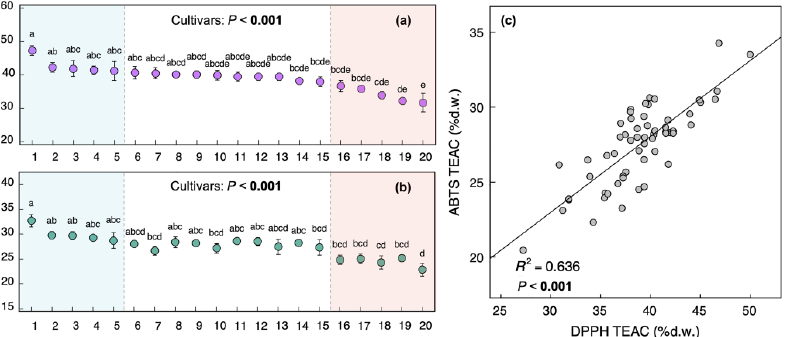
Figure 1. Variations in radical scavenging capacity within tea leaves across 20 tea cultivars. Radical scavenging capacity is presented as Trolox equivalent antioxidant capacity (TEAC). ( a ) TEAC in DPPH (2,2-diphenyl-1-picrylhydrazyl) radical scavenging assay; ( b ) TEAC in ABTS (2,2′ -azinobis- (3-ethylbenzothiazoline-6-sulfonic acid) radical scavenging assay; ( c ) correlations between DPPH TEAC and ABTS TEAC. Dots in ( a , b ) represent mean value ± SE (n = 3 plot replicates). Each point in ( c ) represents results from each sample plot. Different lowercase letters indicate significant differences among cultivars ( p < 0.05). Cultivars highlighted in pink and blue are selected as a subset of cultivars with high (cultivars 16 – 20) and low antioxidant capacities (cultivars 1 – 5) for further analysis. % d.w. = % foliar dry weight. Tea cultivars: 1 Jin Mudan; 2 Hanlv; 3 Ju Hua Xiang; 4 Tie Guanyin; 5 Tai Xiang Zi; 6 Jin Guanyin; 7 Da Hong Pao; 8 Longjing 43; 9 Cui Yun; 10 Zhongcha 111; 11 Biyun; 12 Zhonghuang No. 2; 13 Longjing Changye; 14 Zhongcha 302; 15 Zhonghuang No. 1; 16 Zhongcha 108; 17 Fuan Da Bai; 18 Zhongcha 102; 19 Fuding Da Bai; 20 Jin Xuan.